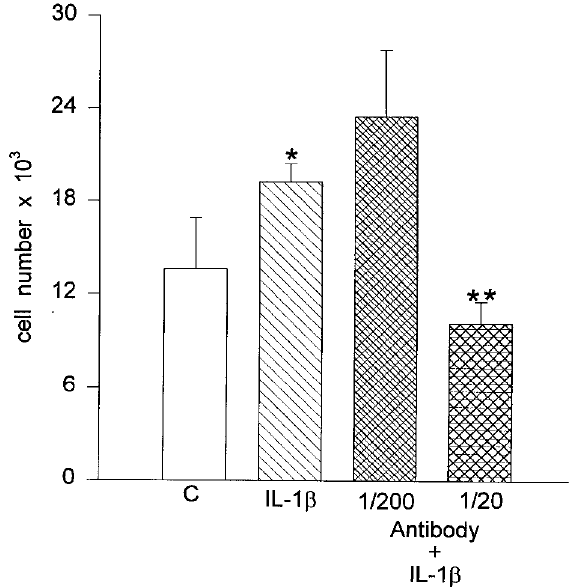
FIG. 1. Inhibition of human interleukin-1 b -induced leukocyte recruitment to peritoneal cavity of rats by subcutaneous injection of an antibody against human IL-1 b . Cell counts were performed 4h after i.p. injections. Control bar (C) represents counts of leukocytes from animals injected i.p. with 1ml of sterile physiological saline. Sterile IL-1 b was injected i.p. at 1.45 3 10 –10 M. Dilutions of the antibody were also made in physiological saline. *Represents P < 0.05 (Anova t -test) compared with control animals ( n =5–7).**Represents P < 0.01 from comparison with IL- 1 b -injected animals (Anova t